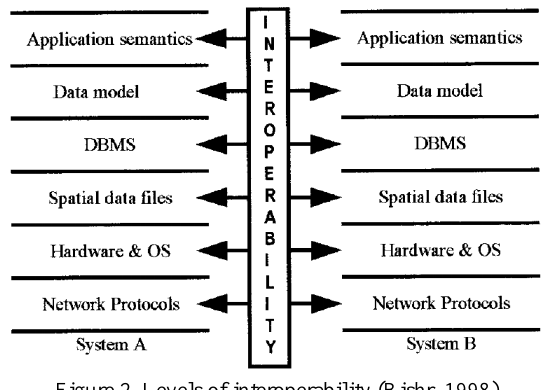
Figure 2. Levels of interoperability (Bishr,